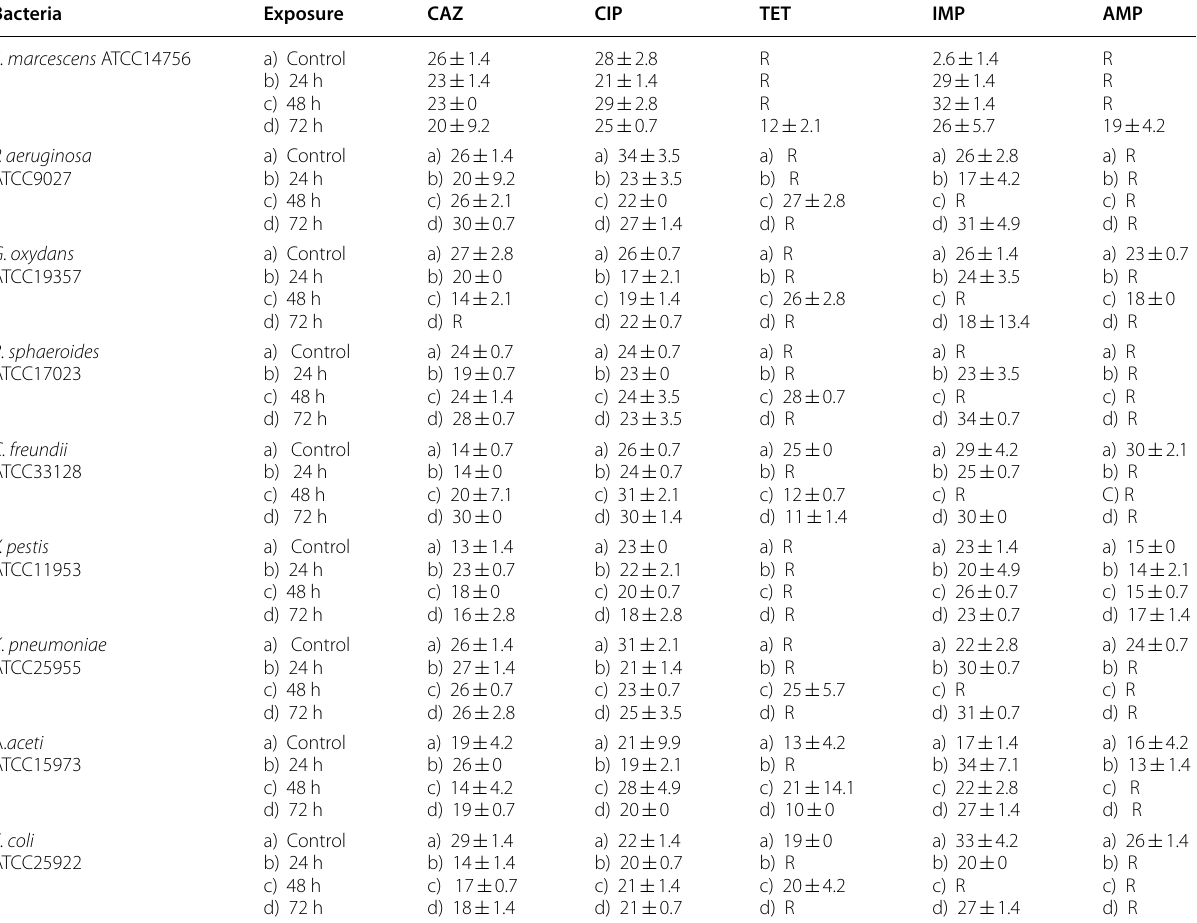
Table 3 Antibiotics susceptibility profile for selected Gram‑negative bacteria as read in mean diameter of zones of inhibition (mm) after exposure to acoustic treatment at 1125 Hz/80 dB compared with